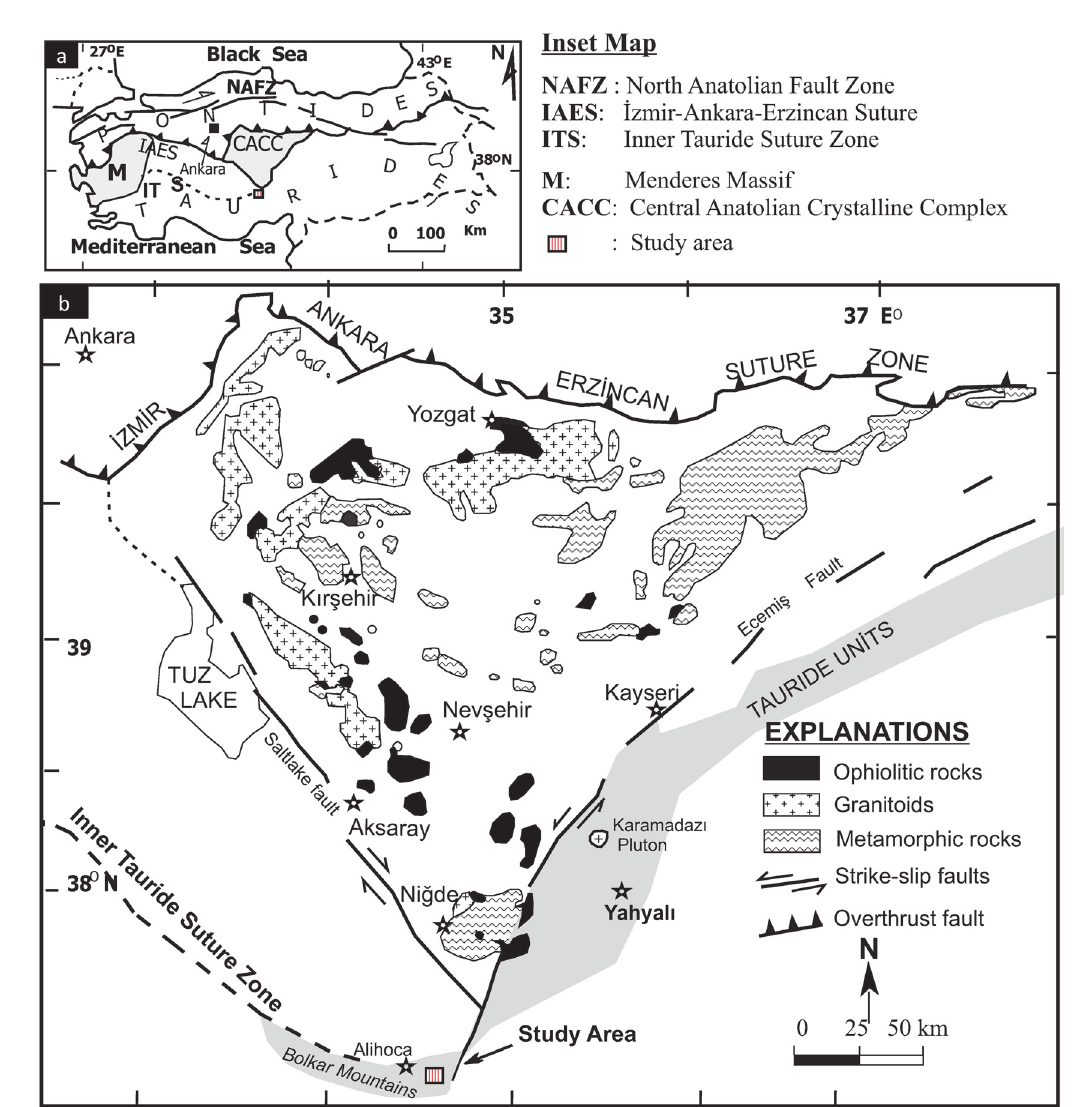
Fig. 1. Generalized geological sketch map of the main lithologic units of the Central Anatolian Crystalline Complex (after Bingol